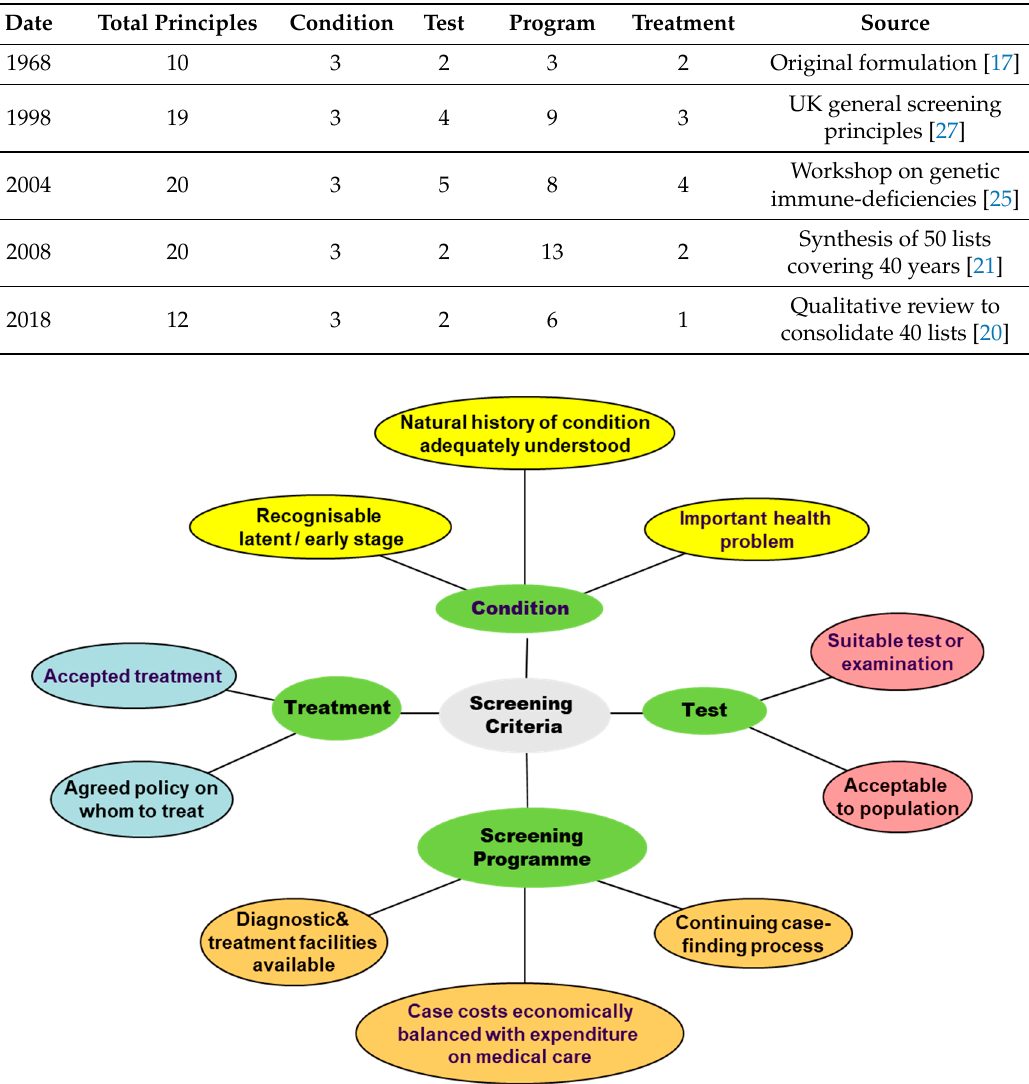
Figure 2. The 10 criteria for a health screening program developed by Wilson and Jungner (outer ring), in four recognized groups. Developed from [17], [27] and [29].